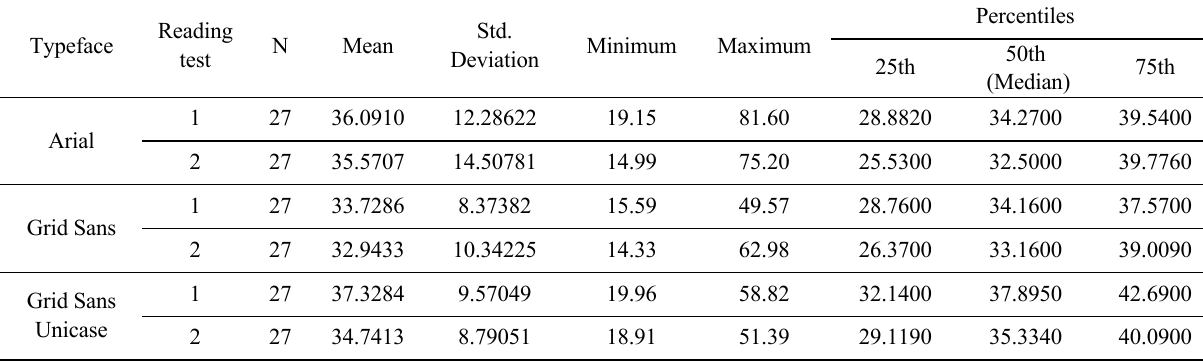
Table 4. Reading tests descriptive